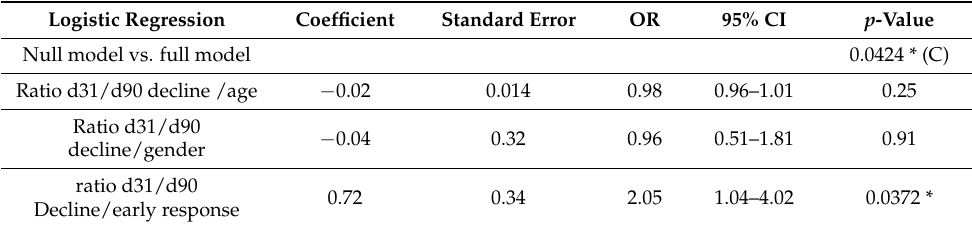
Table 2. Logistic regression analysis of predictors of antibody decline 90 days after the first BNT162b mRNA dose. Logistic Regression Coefficient Standard Error OR 95% CI p -Value Null model vs. full model 0.0424 * (C) Ratio d31/d90 decline /age − 0.02 0.014 0.98 0.96–1.01 0.25 Ratio d31/d90 − 0.04 0.32 0.96 0.51–1.81 0.91 decline/gender 0.72 0.34 0.0372